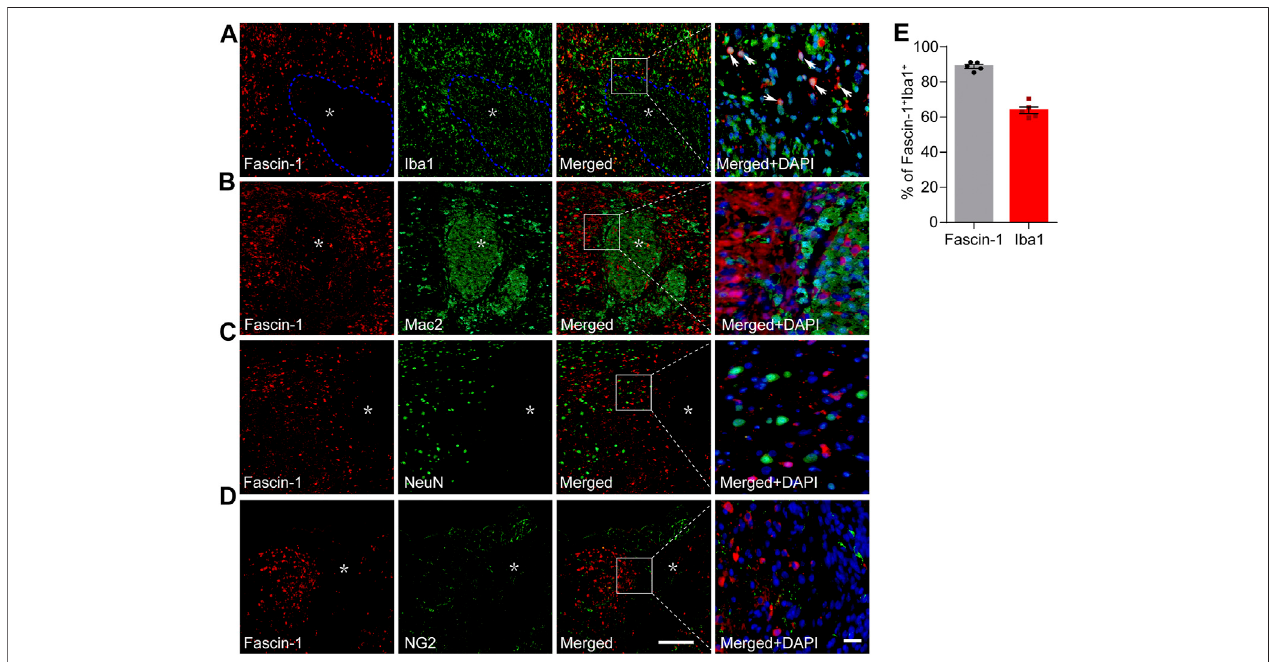
FIGURE3| Fascin-1isexpressedpartlyinIba1 + cellsaroundthelesionbutnotinin fi ltratingMac2 + macrophages,NeuN + neuronsorNG2 + cellsintheinjuredspinal cord at 14 days. (A) Representative immuno fl uorescence images of Fascin-1 (Red) and Iba1 (Green). Arrowheads indicate the colocalization observed with a × 40 objective lens. The blue dotted lines delineate the boundary around the lesion core. (B – D ) Representative immuno fl uorescence images of Fascin-1 (Red) staining with Mac2, NeuN, and NG2 (Green) staining, respectively, showing no apparent colocalization of staining. The asterisks indicate the lesion epicenter. Nuclear staining with DAPI is shown (Blue). Scale bars: low magni fi cation, 200 μ m; higher magni fi cation, 20 μ m. (E) Percentage of Fascin-1 + Iba1 + cells relative to the total number of Fasicn-1 + or Iba1 + cells outside the blue dotted lines in the injured spinal cord. The data are presented as the mean ± SEM ( n (cid:2) 5 independent